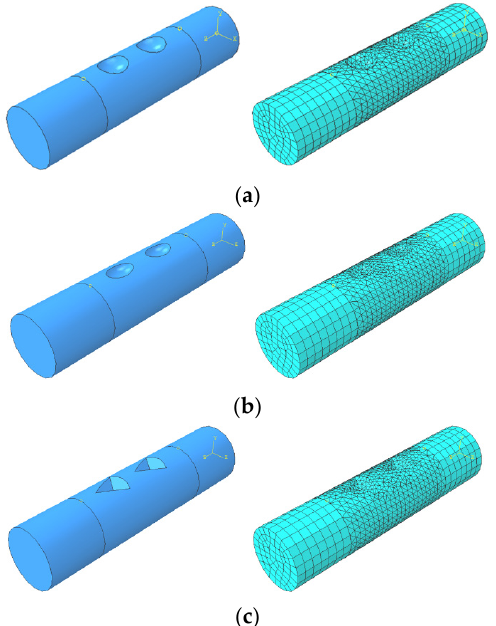
Figure 7. Finite element models: ( a ) FEA model of corroded reinforcement with circular pits; ( b ) FEA model of corroded reinforcement with ellipsoidal pits; ( c ) FEA model of corroded reinforcement with triangular pyramid pits.